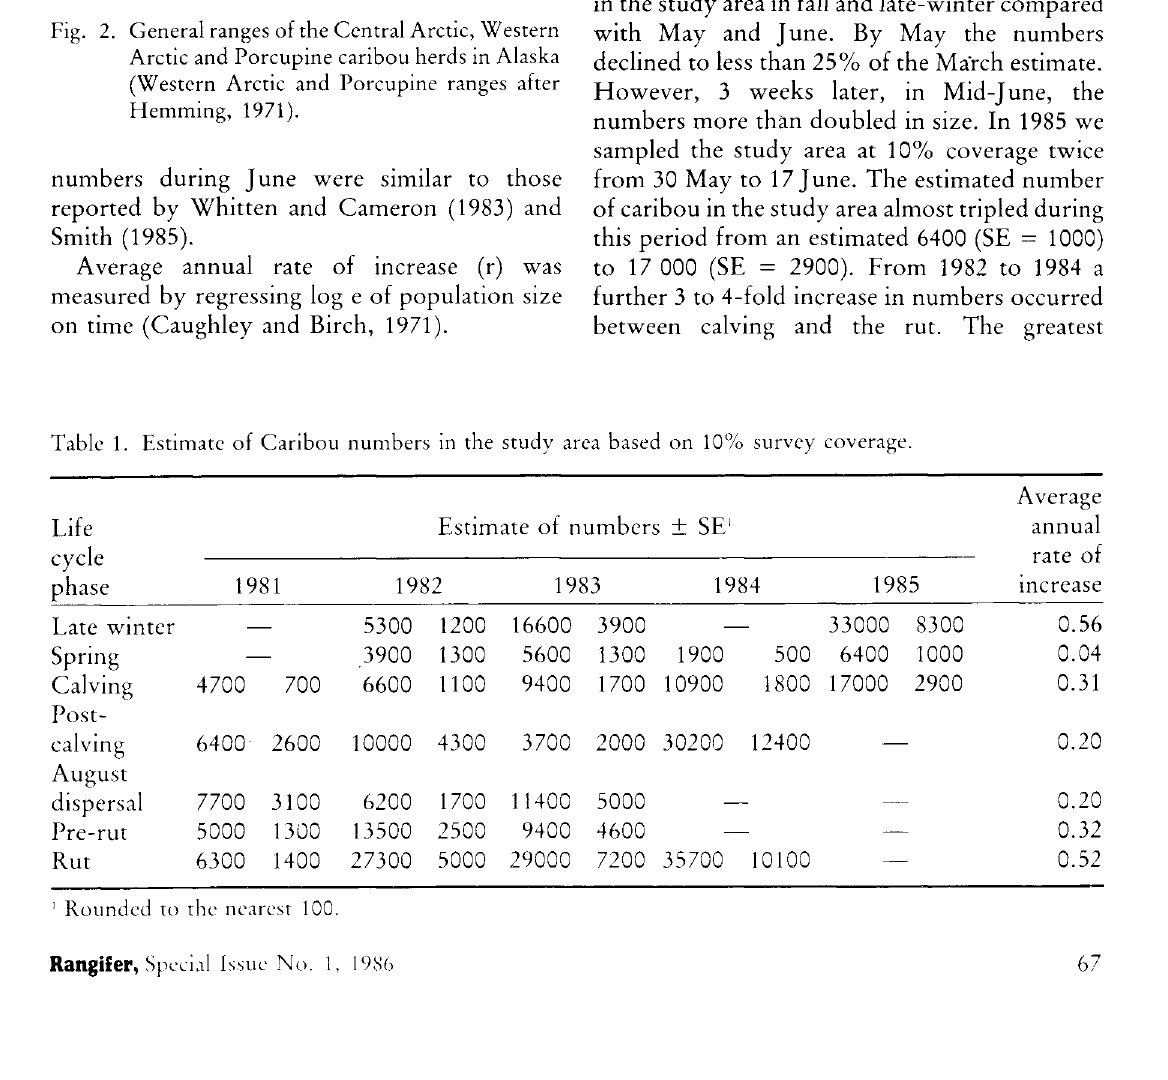
Rounded to the nearest